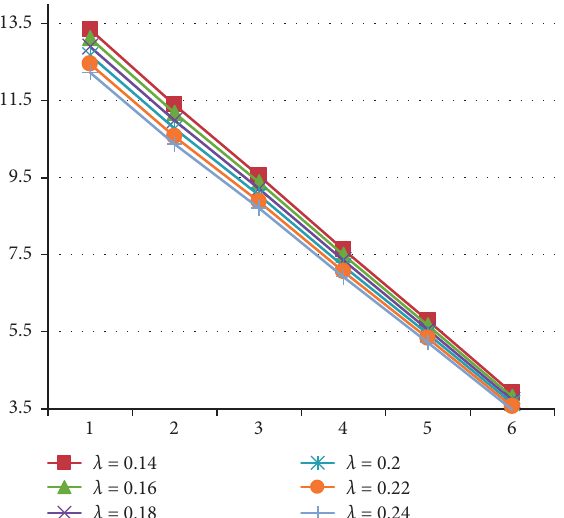
Figure 12: The LSI’s profit when selecting different CODPs under the premise that λ takes different values.